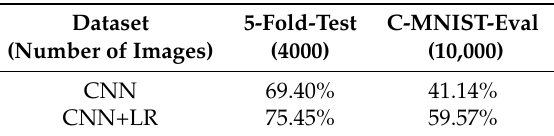
Table 3. Performance of the CNN as compared to CNN with F I F A -driven improvements both on the average of the five folds of test data (5-fold-test) and on entirely corrupted test data (C-MNIST-eval). The improvements by the classifier ensemble are for the best performing parameters. The F I F A -driven improvement produces an 18.43%pt increase in accuracy on the C-MNIST-eval dataset, which consists of only corrupt MNIST images. In addition, the percentage of clean images of the adjusted predictions by the correction layer was only